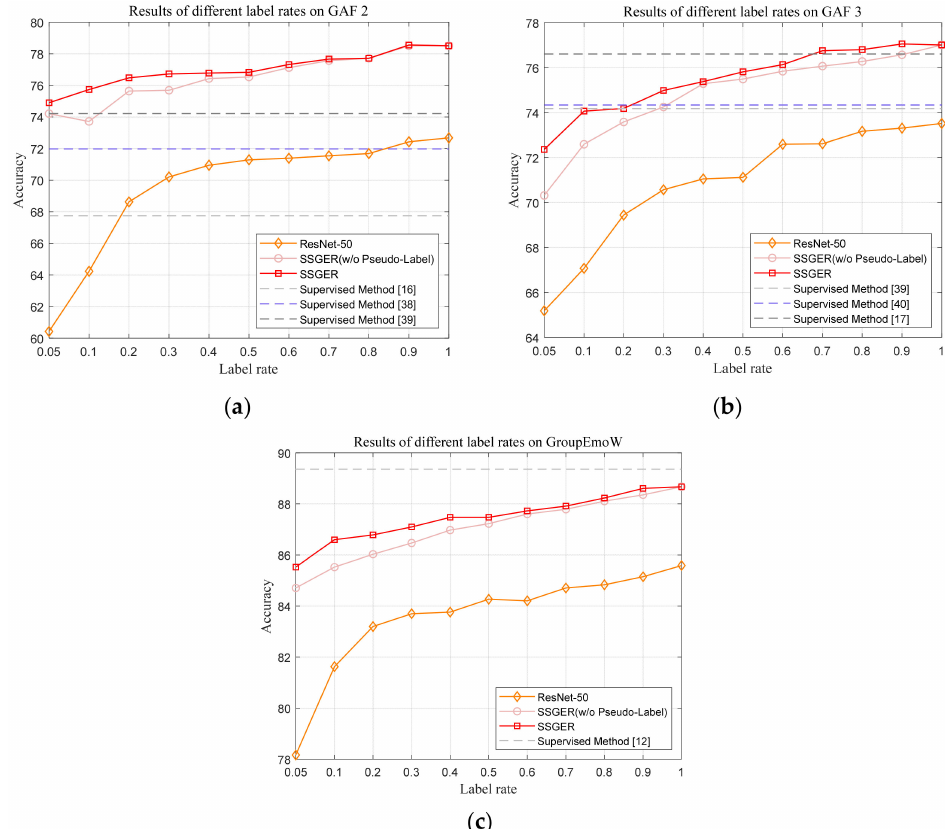
Figure 5. Accuracies of compared methods at different label rates on the GAF2, GAF3, and GroupE- moW datasets. The orange curve with diamonds shows the results of ResNet50 in the semi-supervised scenario. The pink curve with circles shows the results of our framework without using pseudo-labels. The red curve with rectangle shows the results of our SSGER framework using psedo-labels. The dashed lines denote the results of distinct state-of-art supervised methods in GER. ( a ) Results on GAF2; ( b ) results on GAF3; ( c ) results on